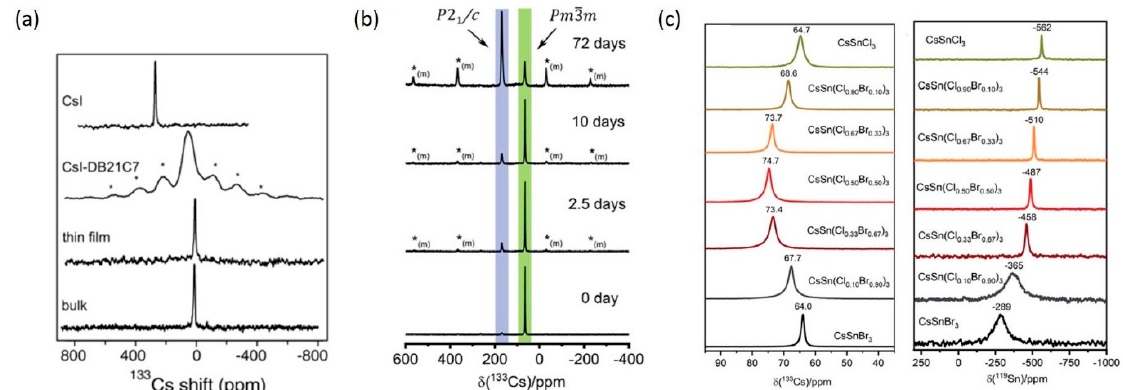
Figure 3. ( a ) 133 Cs MAS spectra of crystalline CsI, CsI–DB21C7 powder, FAPbI 3 thin film treated with CsI–DB21C7 (thin film) and a sample of FAPbI 3 mixed with the CsI–DB21C7 complex (bulk); * indicate 133 Cs spinning sidebands. Reprinted with permission from ref. [82]. Copyright 2021 Springer Nature. ( b ) Time-dependent 133 Cs NMR spectra of CsSnCl 3 . The asterisks (*(m)) indicate positions of spinning sidebands for the monoclinic phase. ( c ) Left: room temperature 133 Cs NMR spectra for CsSn(Cl 1-x Brx) 3 ; right: room temperature 119 Sn NMR spectra for CsSn(Cl 1-x Br x ) 3 . Reprinted with permission from ref. [83]. Copyright 2021 Royal Society of Chemistry.